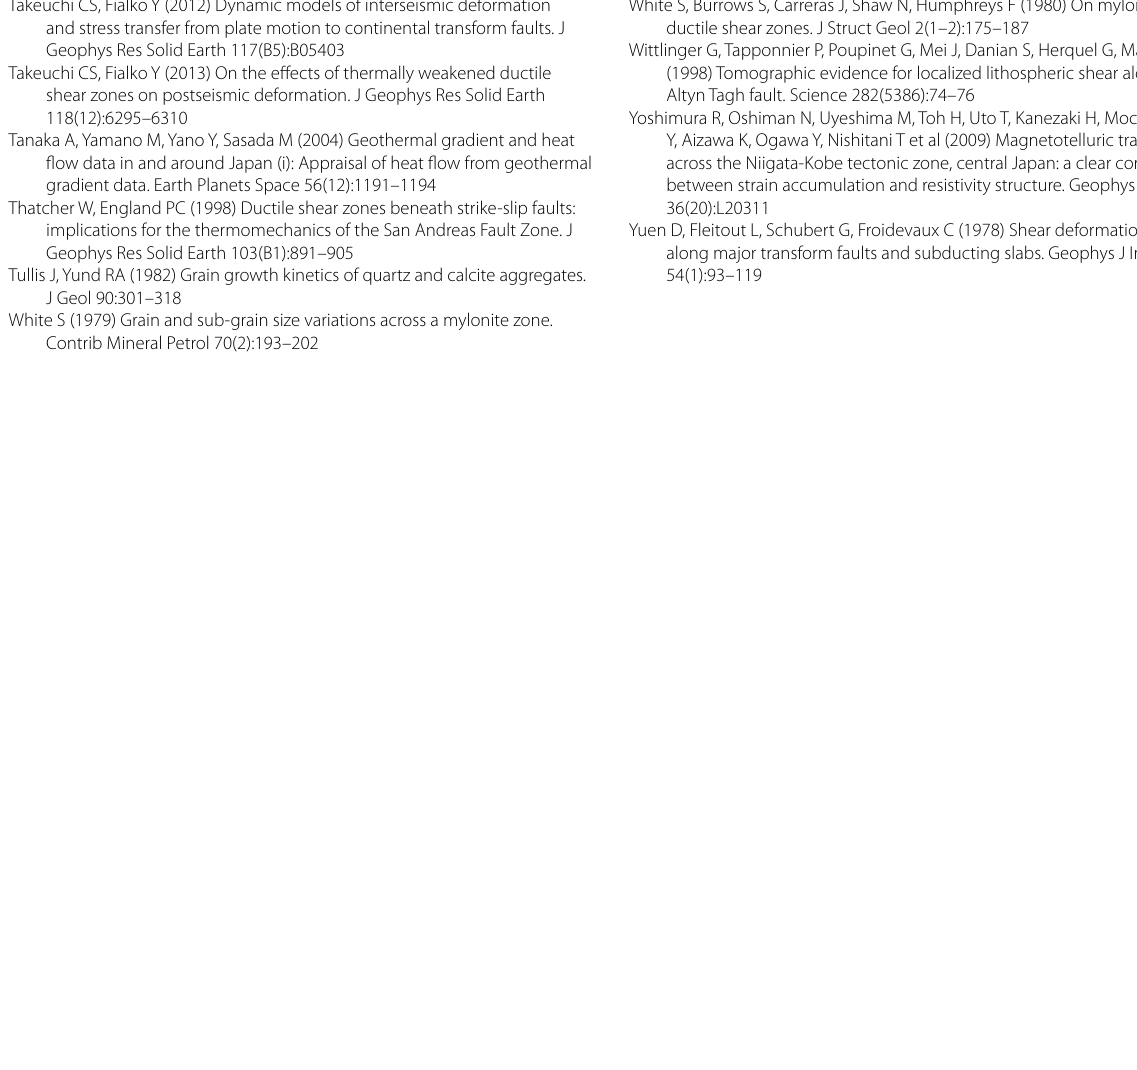
Takeuchi CS, Fialko Y (2012) Dynamic models of interseismic deformation and stress transfer from plate motion to continental transform faults. J Geophys Res Solid Earth 117(B5):B05403 Takeuchi CS, Fialko Y (2013) On the effects of thermally weakened ductile shear zones on postseismic deformation. J Geophys Res Solid Earth 118(12):6295–6310